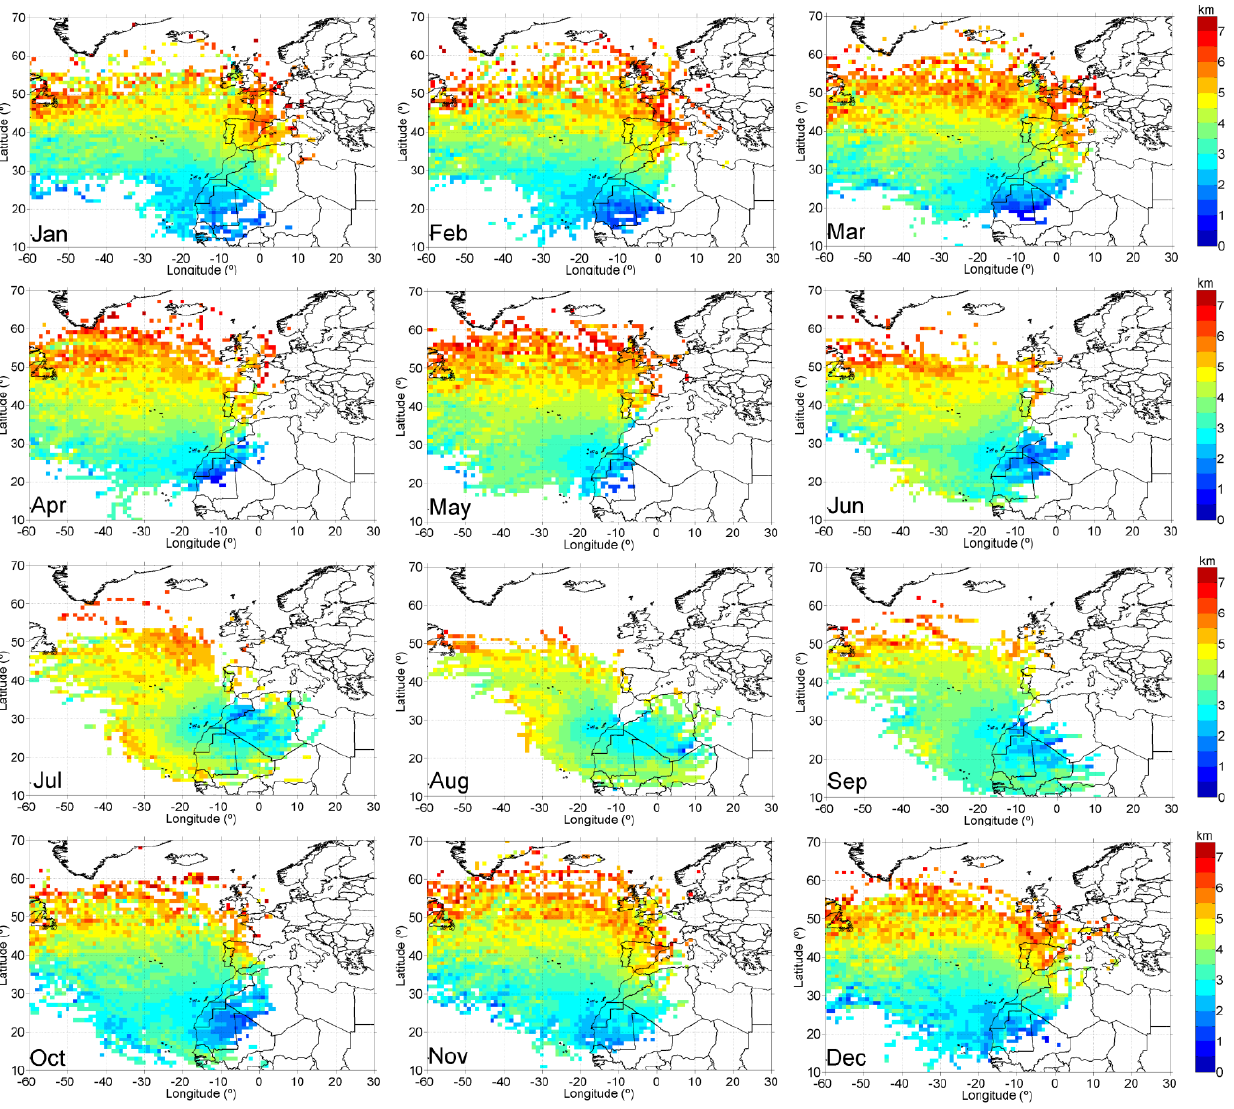
Fig. 6. Backward trajectory mean height plots for each month of the year for the period 1988–2009. Color bars indicate height in kilometers.